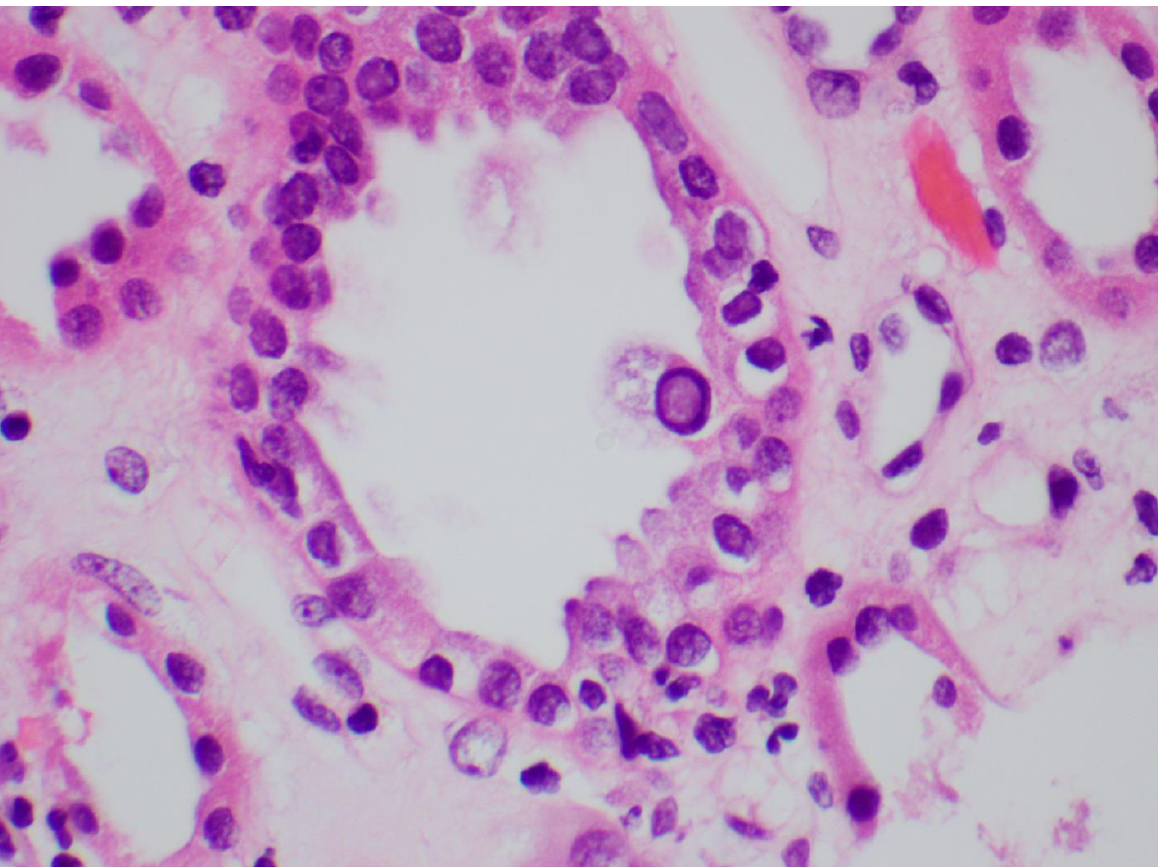
Figure 2. A tubular epithelial cell with a “ground glass” nuclear inclusion. H&E 600 ×.